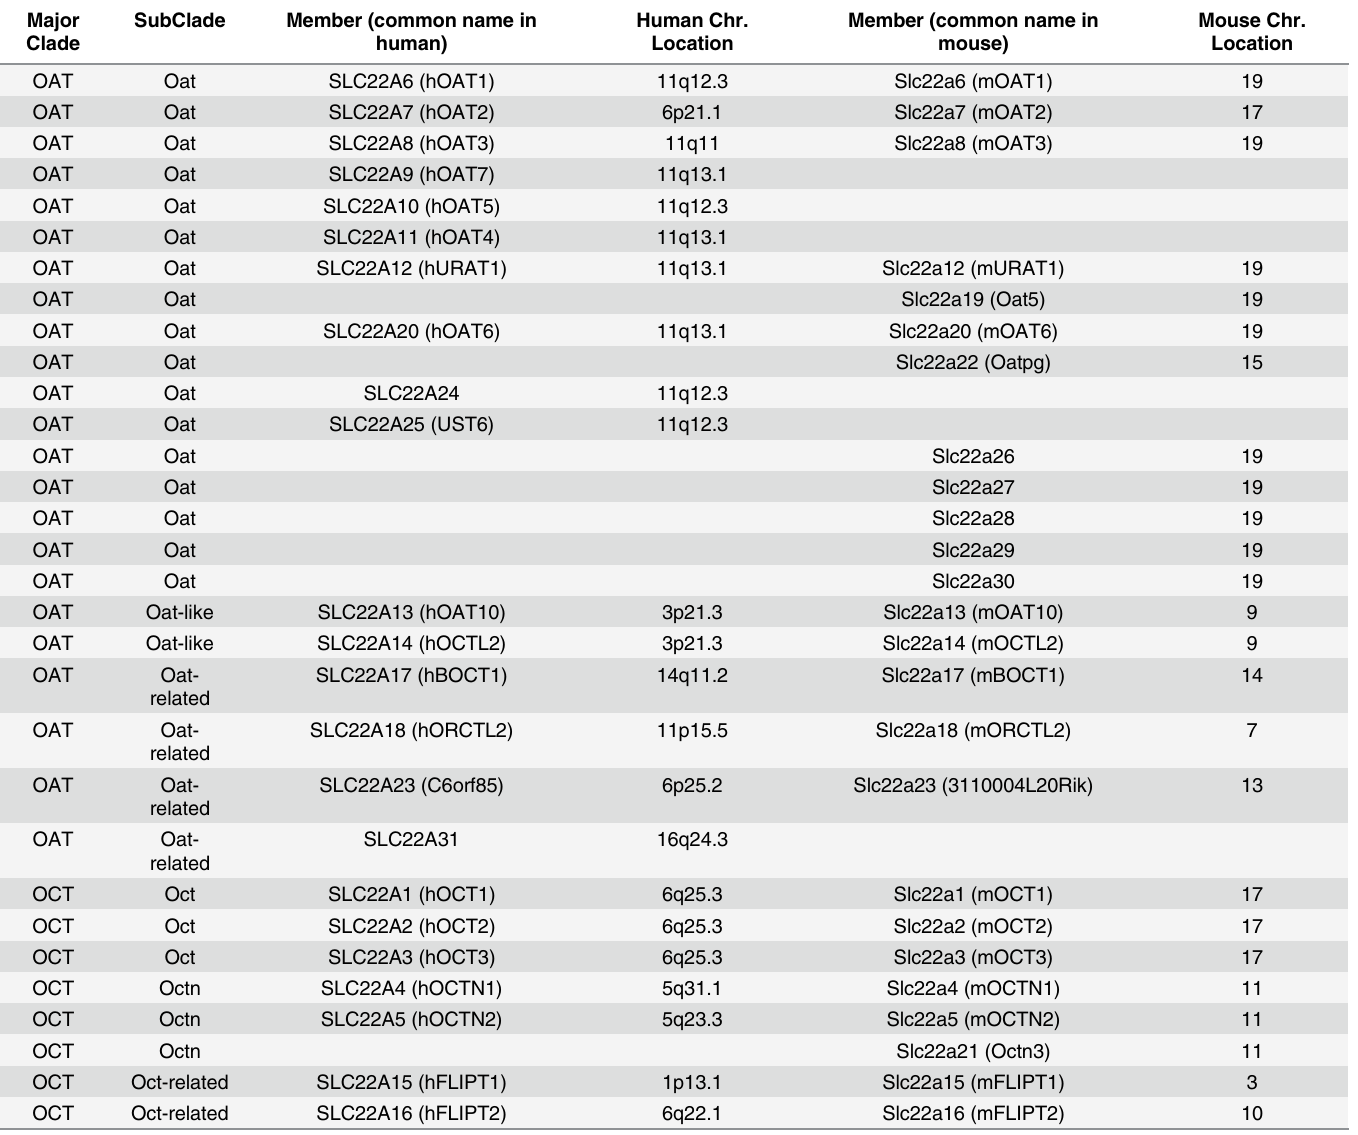
Table 1. List of Major and Sub Clades of SLC22 Family Members in Human and